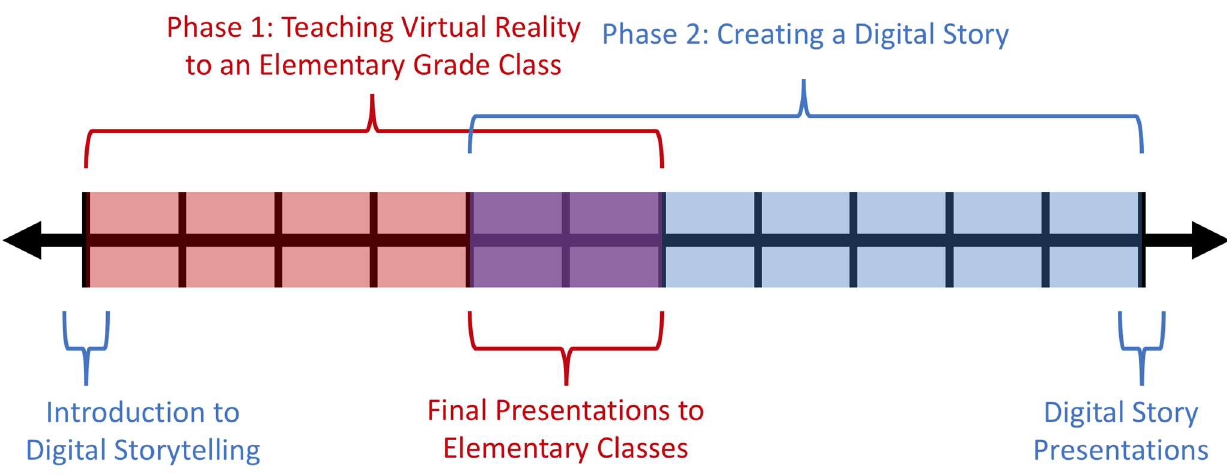
Figure 1: Project Completion